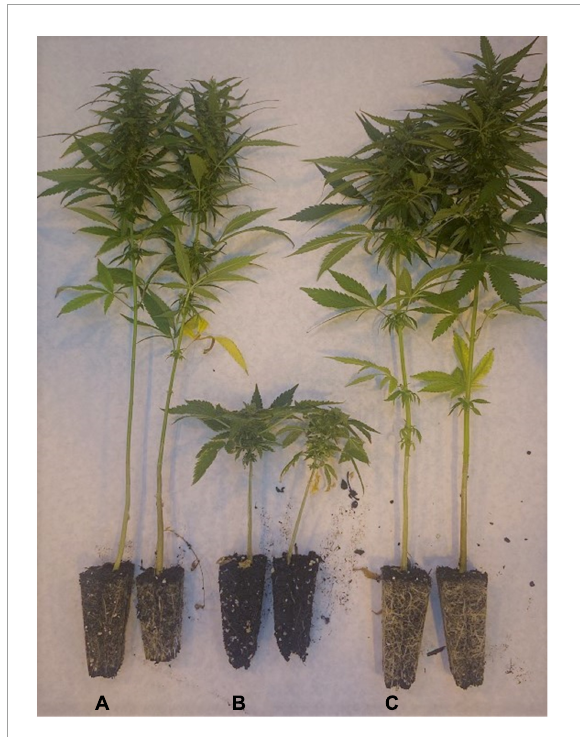
FIGURE3 Photoperiod-insensitive C. sativa grown under long days (16L:8D) and photographed 85 days after planting. Representative female plants of panel (A) ‘Picolo,’ (B) ‘Le Crème’ ( Autoflower1 / Autoflower1 ), and (C) ‘Le Crème’ ( Autoflower1 / Autoflower1 ) × ‘Picolo’ F 1 . Receptive white pistils were present at the apex of plants in panels (A,C) at 85 days after planting, but only brown desiccated pistils were present on plants in panel (B) .